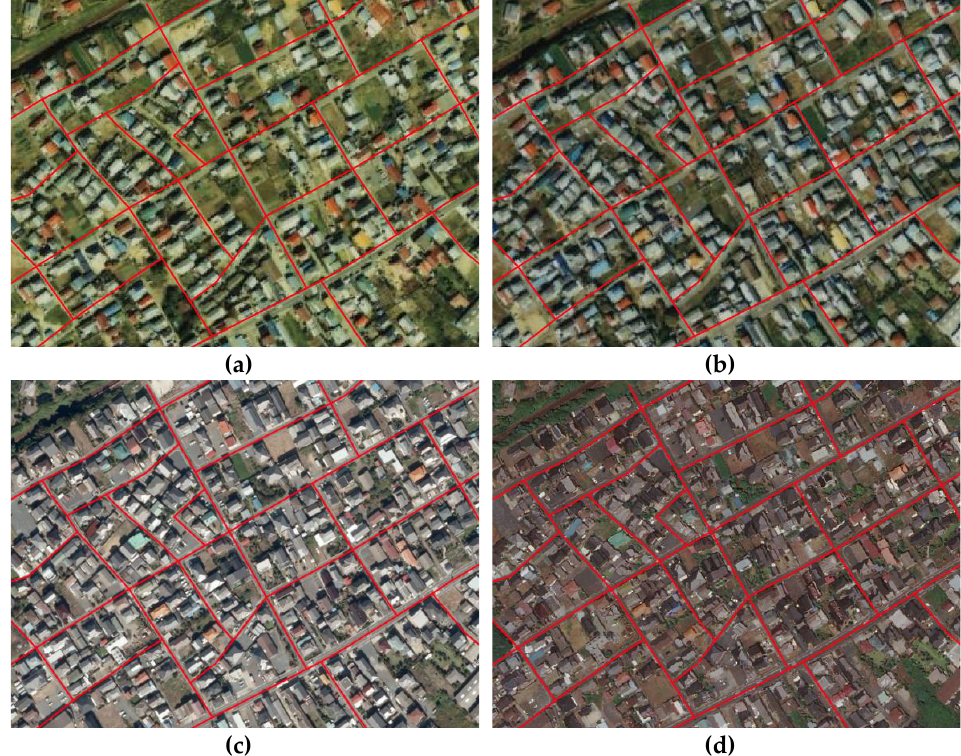
Figure 8. Examples of superimposition with OSM road centerline vector map: (a) old-period aerial photo 1, (b) old-period aerial photo 2, (c) new-period aerial photo and (d) WV-3 image.